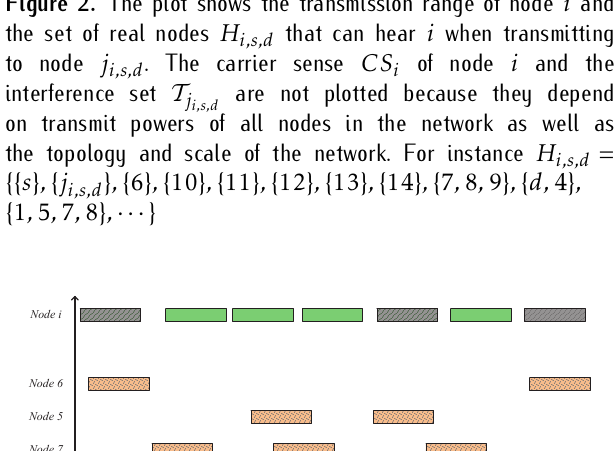
Fig. 2 shows explicitly two di ff erent areas that need to be considered when a couple of